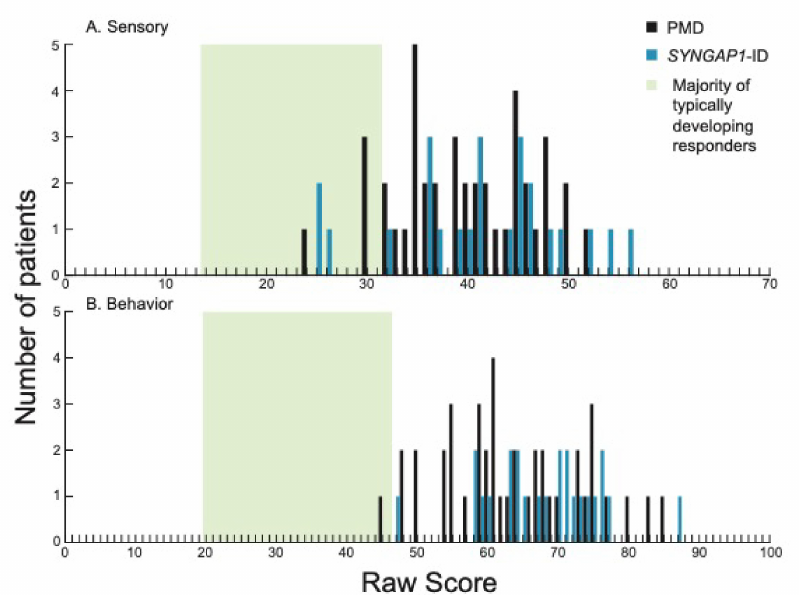
Figure 1. Distribution of scores in each of the two sections on the SSP-2 for PMD and SYNGAP1 -ID. Histograms showing number of PMD patients (black) and SYNGAP1 -ID patients (blue) with each raw score in the sections of ( A ) sensory and ( B ) behavior. Green box indicates range of scores associated with the majority of typically developing responders based on prior validation of the SSP-2 [24]. PMD: Phelan-McDermid Syndrome. SYNGAP1 -ID: SYNGAP1 -related Intellectual Disability. SSP-2: Short Sensory